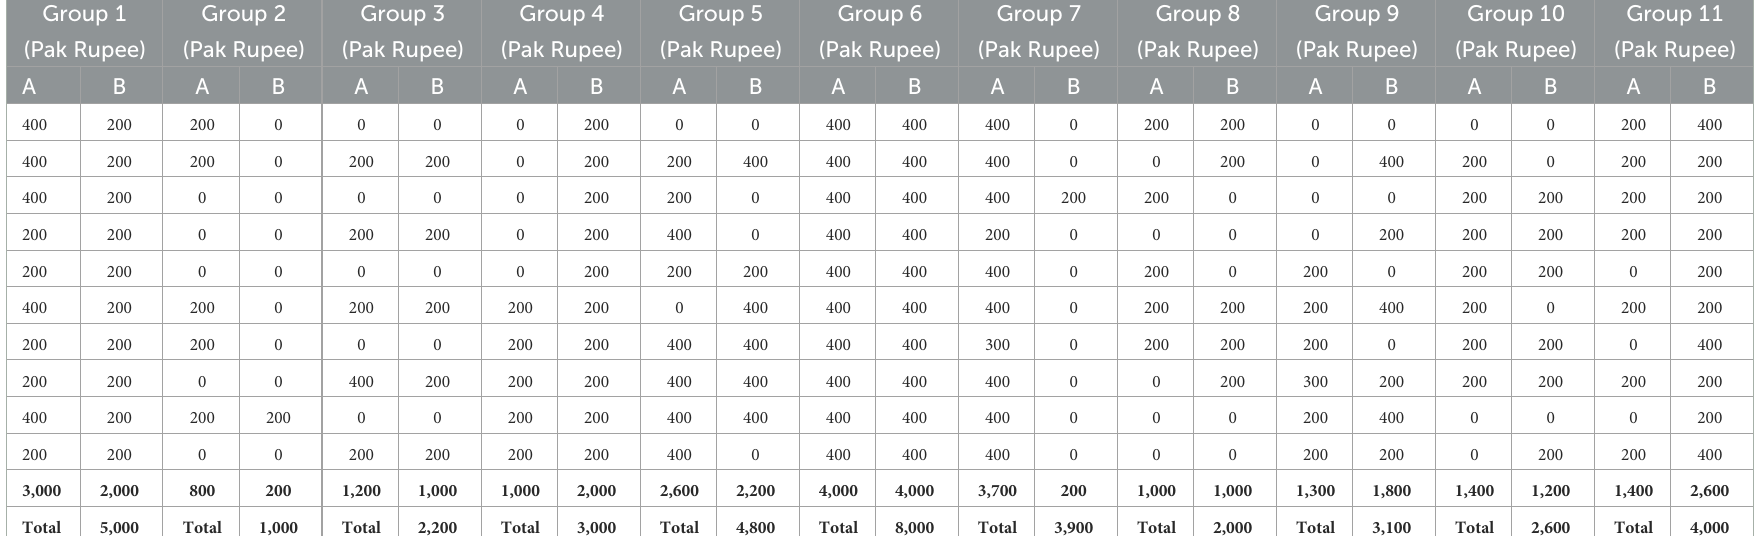
TABLE 1 Results of 10 rounds in experiment I.